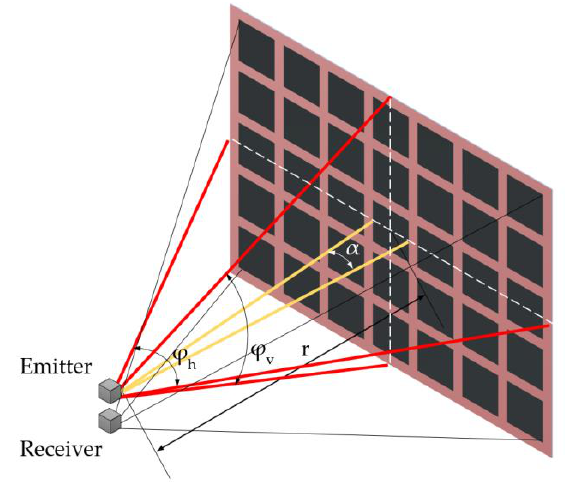
Figure A4. Flash irradiation. Figure A4. Flash